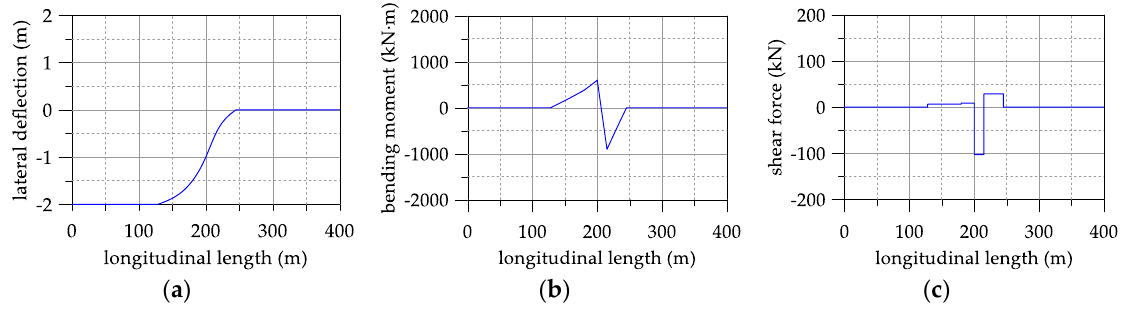
bending moments; ( c ) shear forces. ( b )